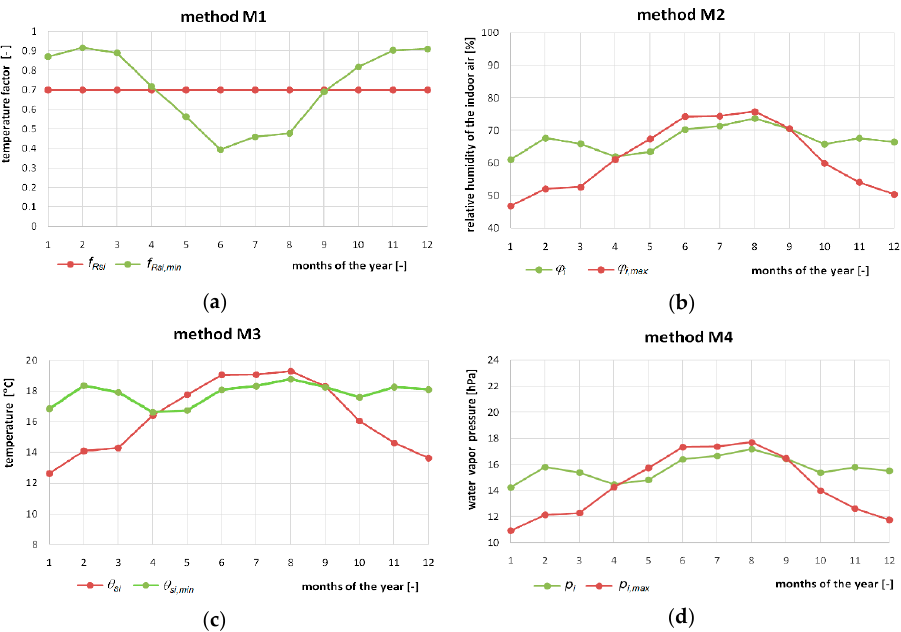
Figure 1. Graphs of characteristic parameters in the phenomenon of mold development; (a) method M1; (b) method M2; (c) method M3; (d) method M4.